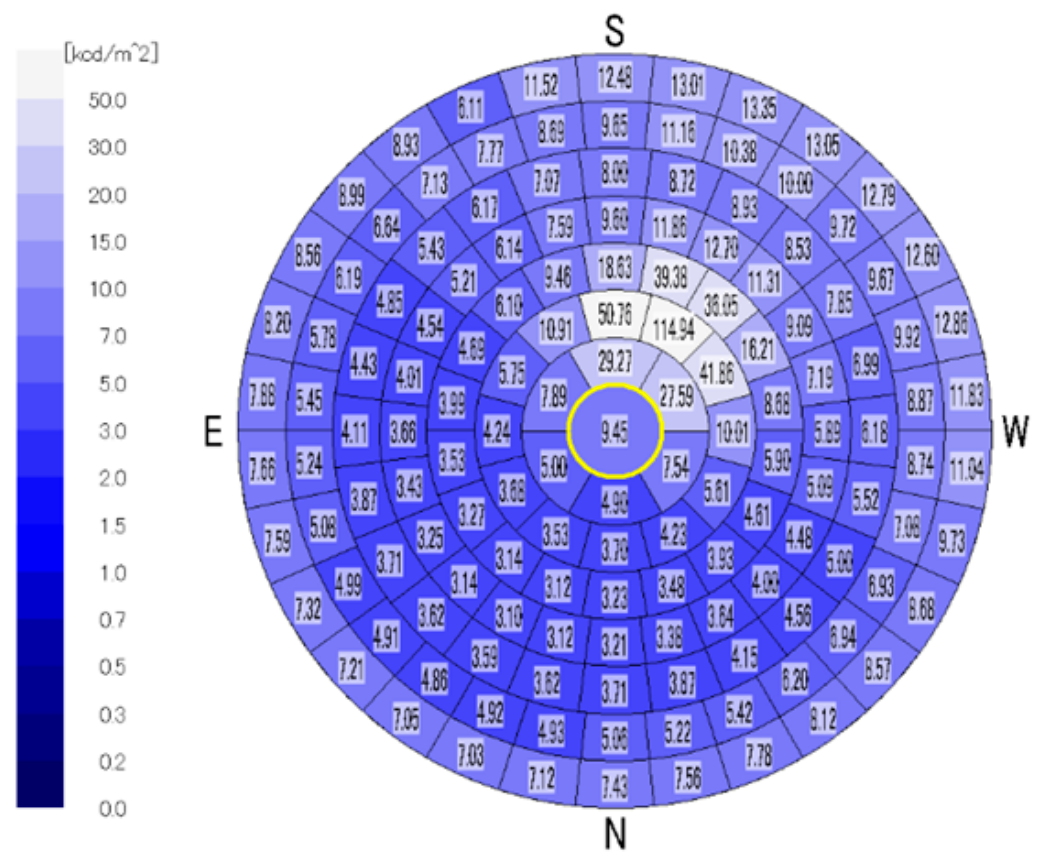
Figure 4. An example of sky luminance distribution measurements, showing the problem of high readings.